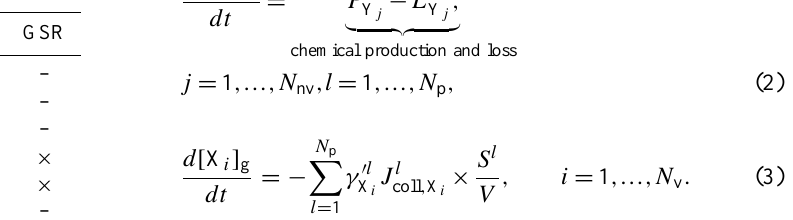
Table 1. List of volatile species considered here that take part in heterogeneous reactions (cf. Table 2) and corresponding processes that they participate in. SLR denotes surface layer reactions and GSR stands for gas-surface reactions. NO 3 does not adsorb onto the particles from the gas phase but is produced in the sorption layer by SLR6.